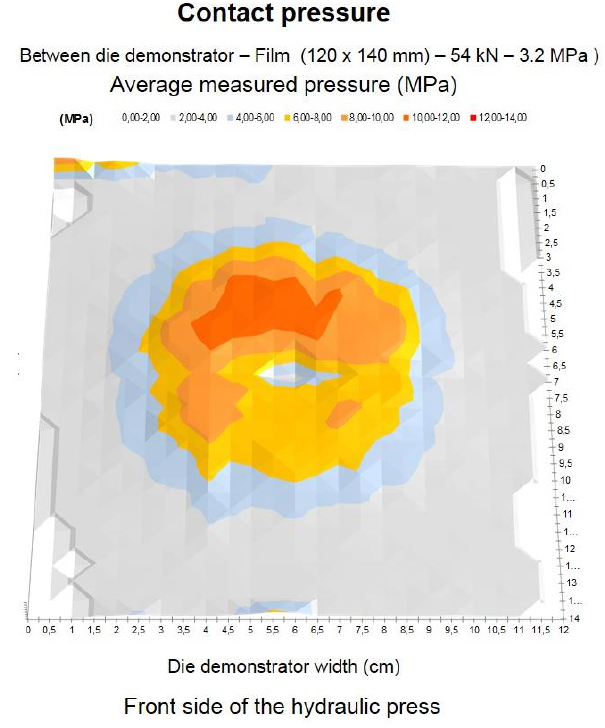
Figure 6. Pressure distribution in a 3D image.